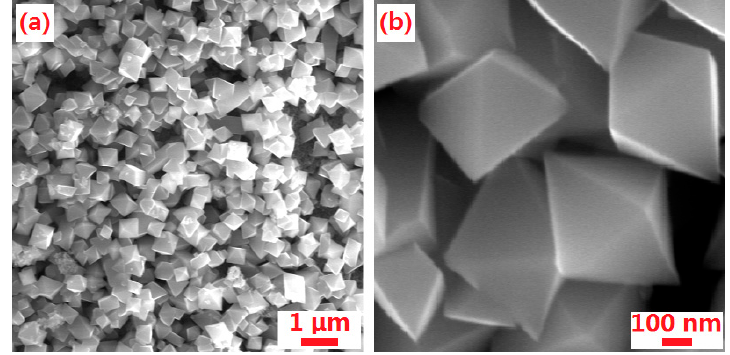
Figure 2. ( a ) The survey spectra of S/Mn 3 O 4 ; ( b ) Mn 2p; ( c ) O 1s and ( d ) S